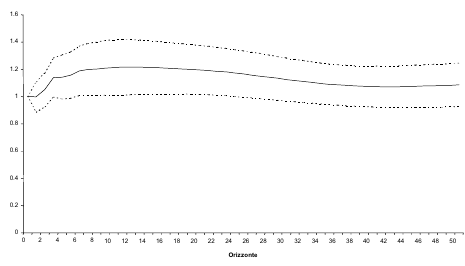
Figura 1d – Profilo di persistenza del settore Beni Non Durevoli (modello M3 ).